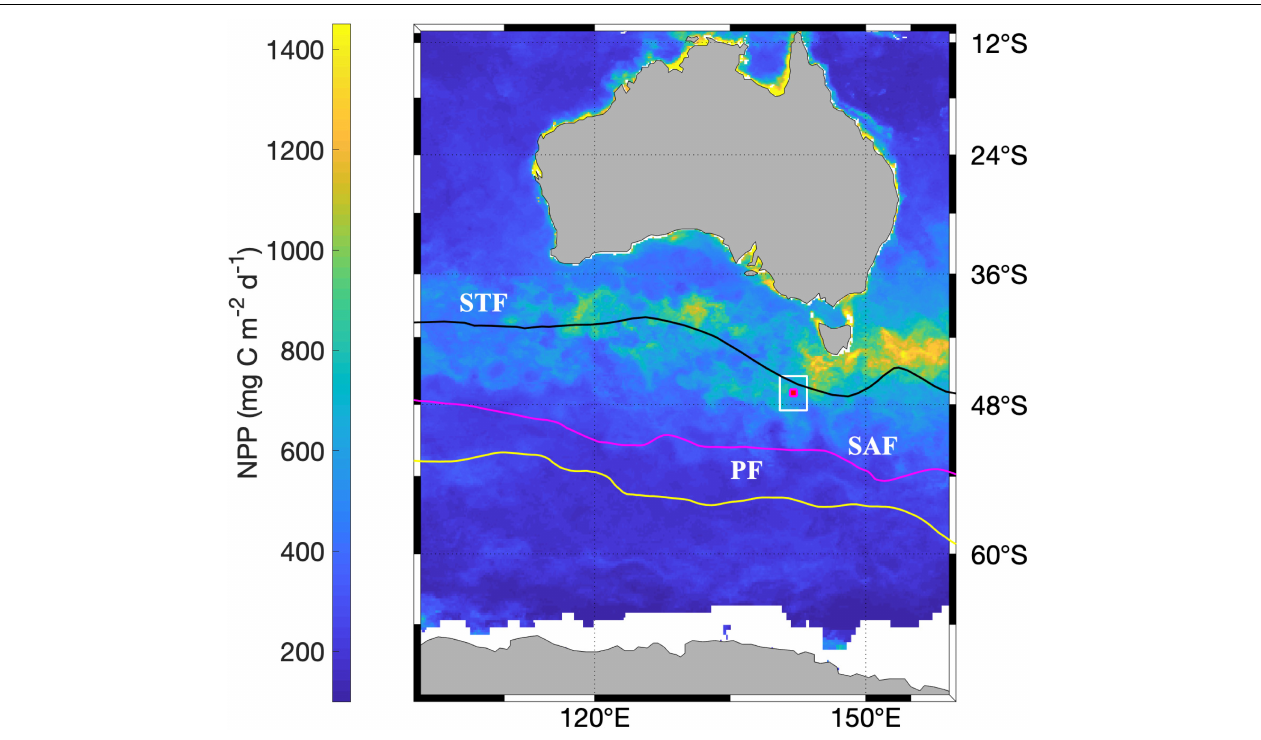
FIGURE 1 | Location of the SOTS site (red dot) relative to average frontal positions (solid lines) : Subtropical Front (STF), Subantarctic Front (SAF), Polar Front (PF). Background is Net Primary Production (illustrated for January 2012) as estimated from satellite remote sensing (see section “Materials and Methods”). The white square indicates the area used for NPP comparisons with SOTS particle